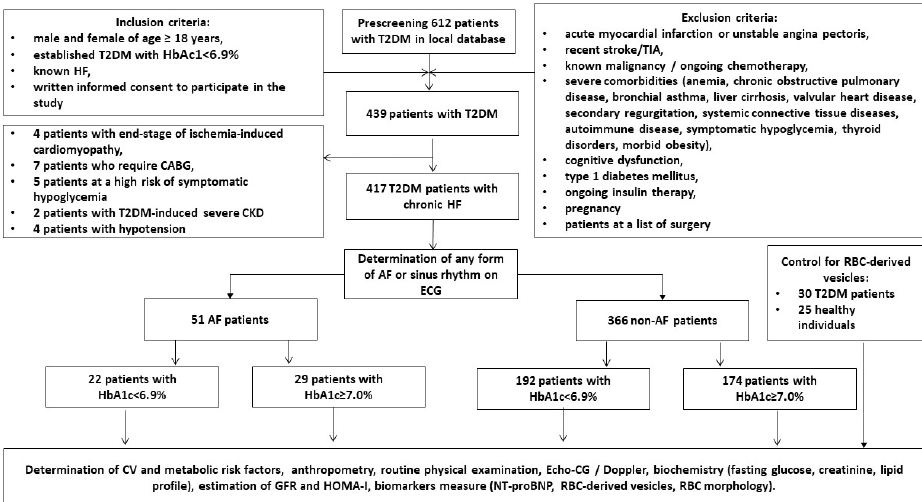
Figure 4. Study design and patients’ procedure flow chart. Abbreviations: AF, atrial fibrillation; CABG, coronary artery bypass grafting; CV, cardiovascular; CKD, chronic kidney disease; GFR, glomerular filtration rate; HF, heart failure; HbA1c, glycated hemoglobin; HOMA-IR, Homeostatic Assessment Model of Insulin Resistance; N-terminal brain natriuretic pro-peptide; T2DM, type 2 diabetes mellitus; TIA, transient ischemic attack.